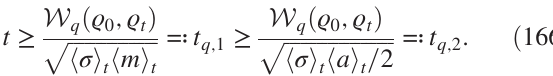
≥ Q as well as the amount of quantum coherence C q; 1 q; 2